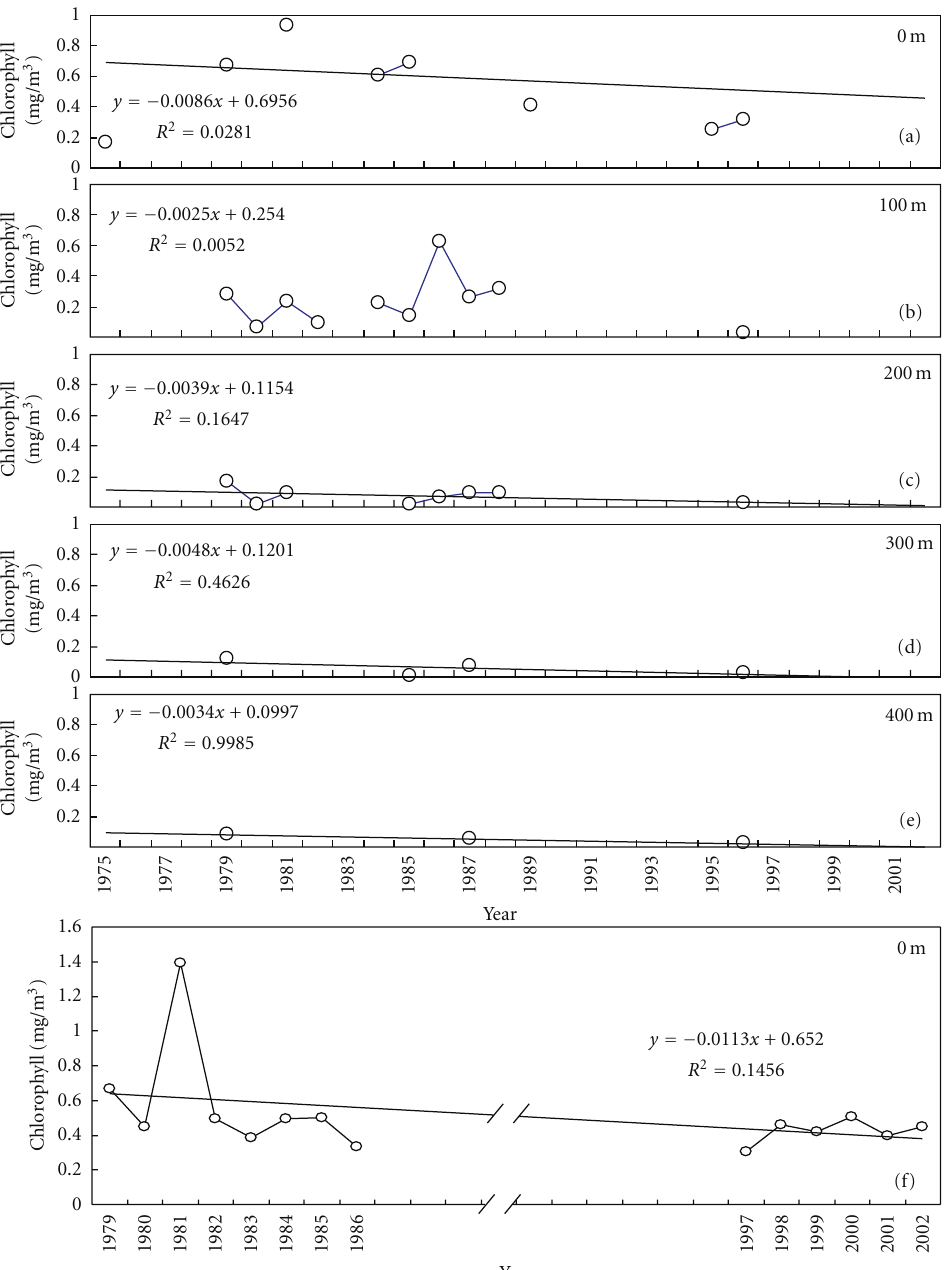
Figure 11: Long-term time series of Chl a concentrations during austral summer (January–March) between 1975 and 2002; (a)–(e) WOD01 and WOD05 data; (f) SeaWiFS. Solid lines represent linear